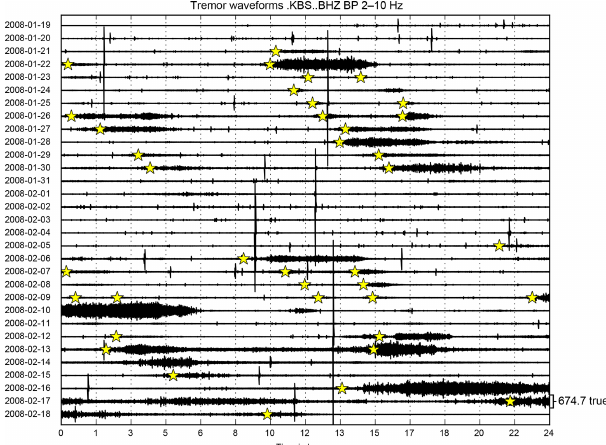
Figure B1. Example of repeating seismic tremor waveforms recorded at KBS. Detected tremor onsets are indicated by yellow stars. Waveform data of the tremor on 22 January 2008 are provided in the Supplement S01.